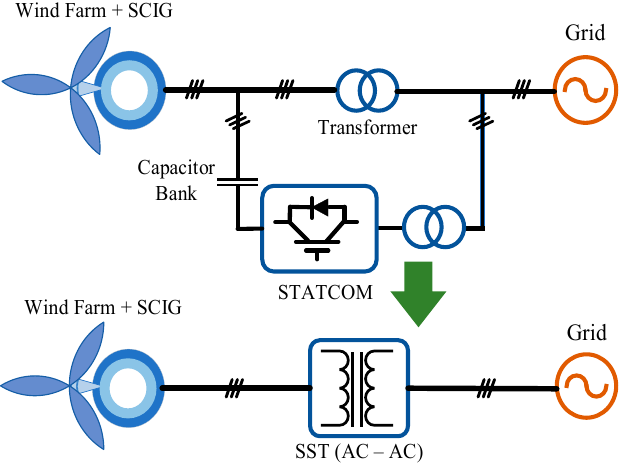
Figure 5. Wind energy system interfaced by SST.